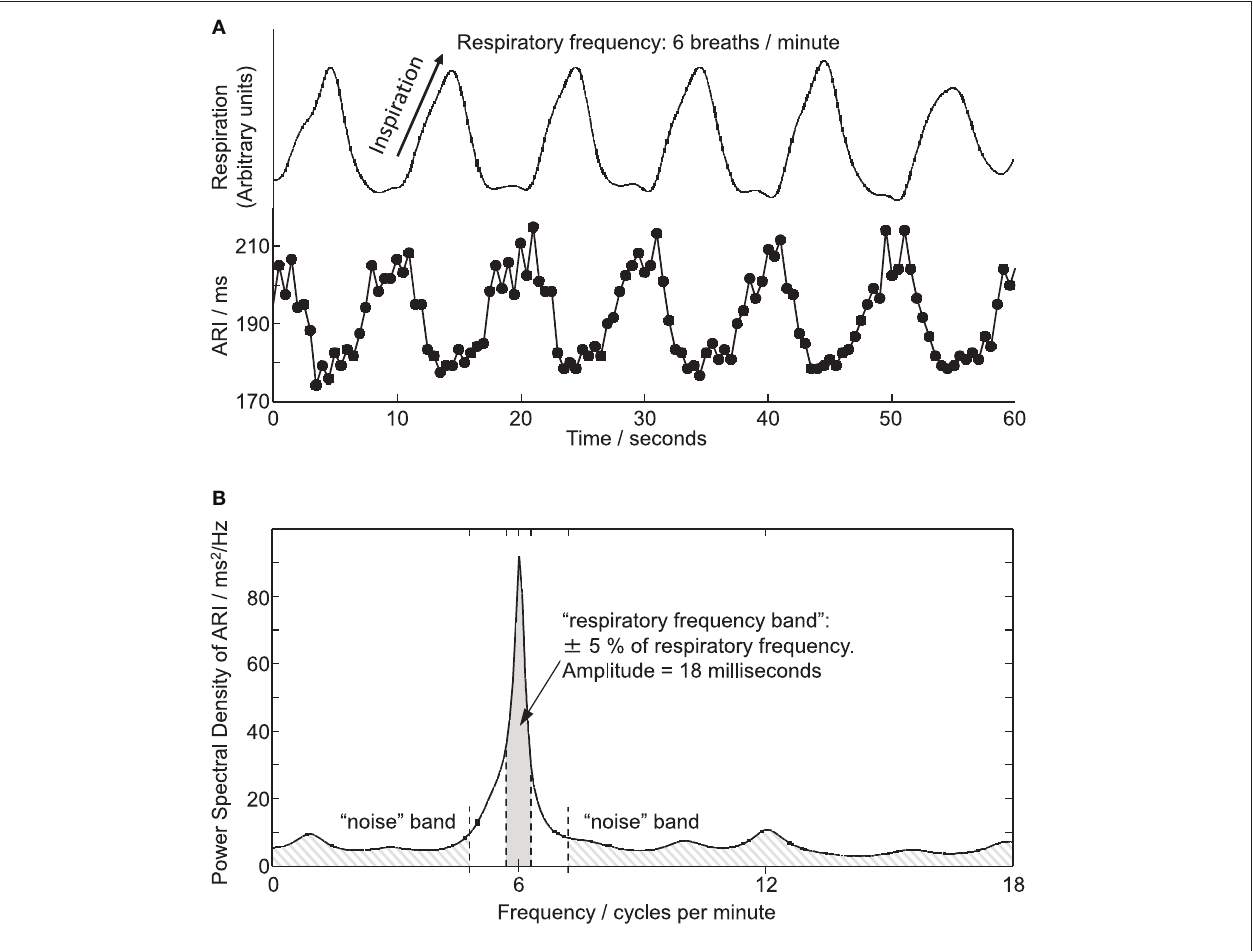
recording. Peak in ARI oscillation coincides with respiratory frequency of 6breaths/min. Shaded areas illustrate frequency bands used for calculating amplitude and statistical significance of oscillations, see “Methods”